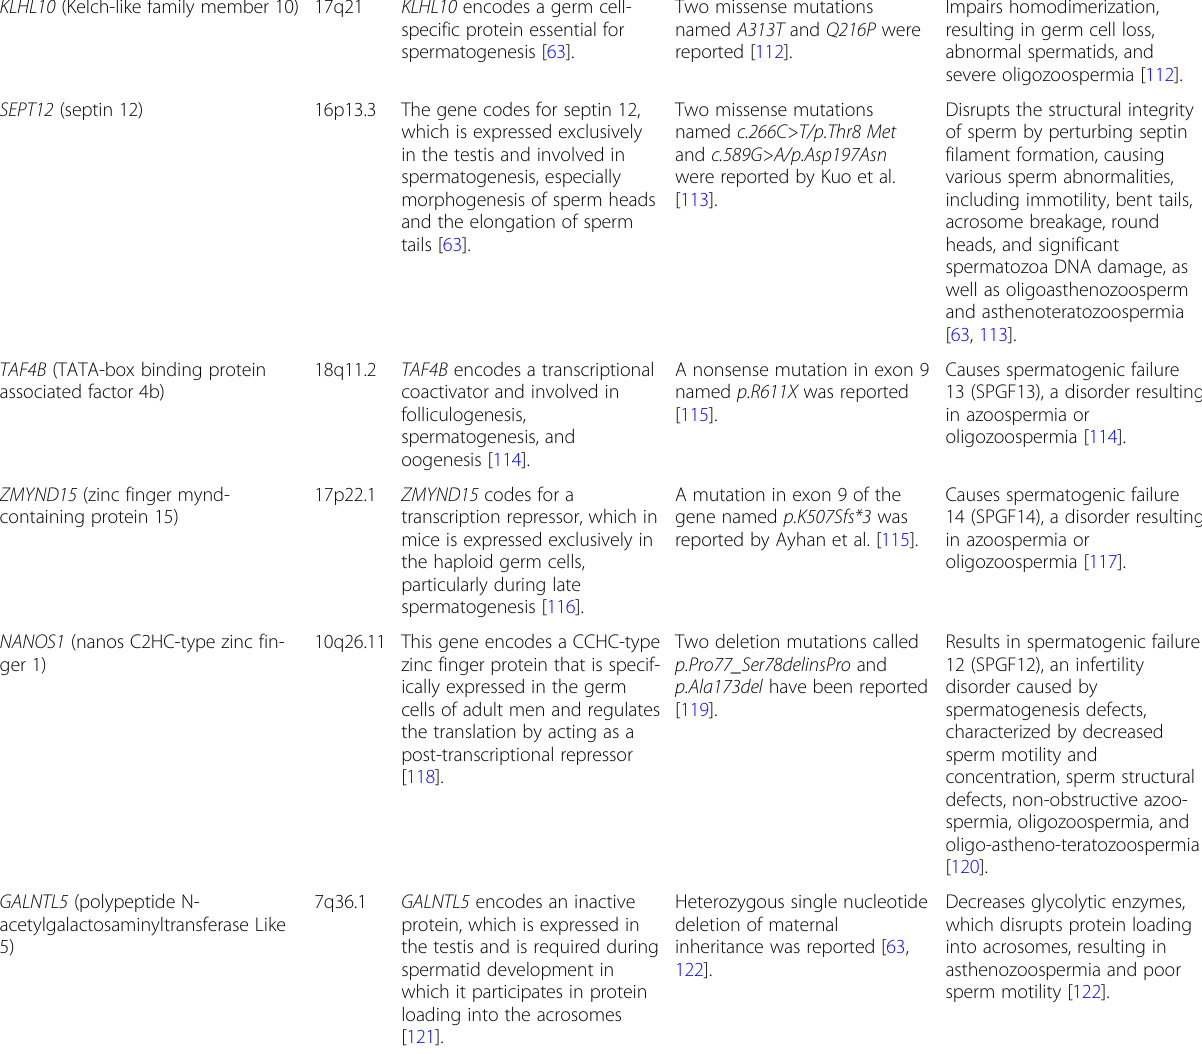
Table 2 Genes predisposing to nonsyndromic spermatogenic failure and sperm morphological abnormalities (Continued) KLHL10 (Kelch-like family member 10)